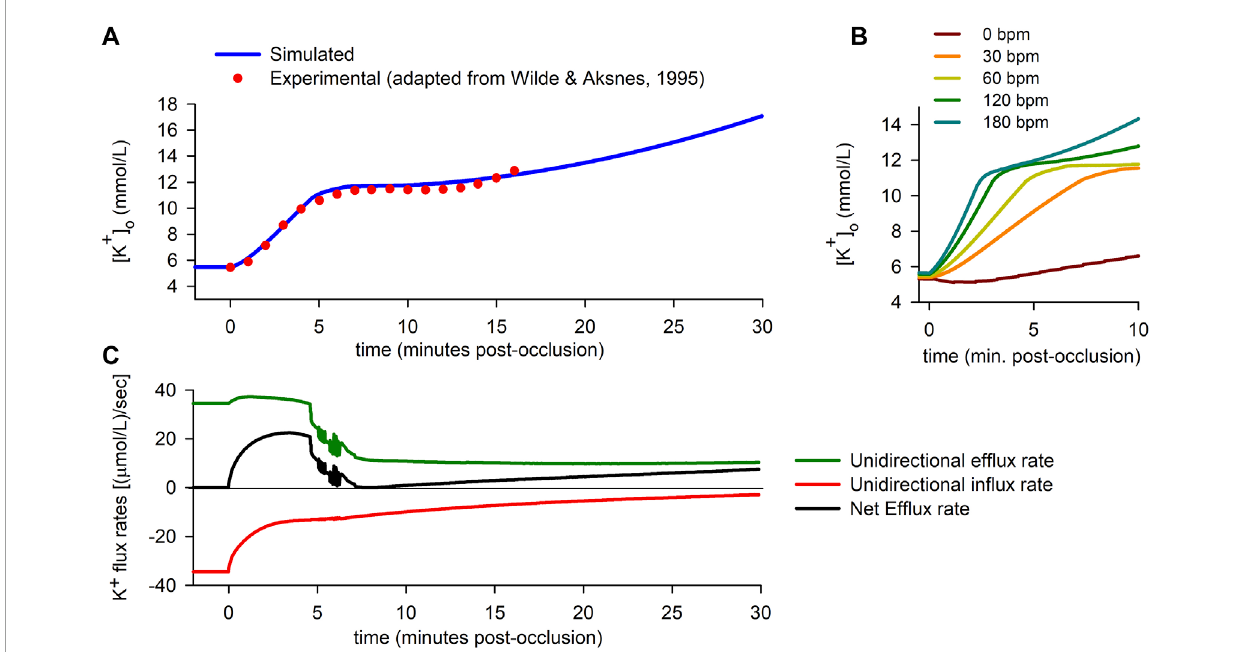
FIGURE 2 Extracellular potassium accumulation and transmembrane potassium fluxes. (A) : Extracellular potassium concentration ([ K + ] o ) vs. time in an isolated ventricular cardiomyocyte subject to progressive ischemia. Solid blue line: simulated result; red circles: experimental data adapted from Wilde and Aksnes (Wilde and Aksnes, 1995). (B) : Simulated time course of [ K + ] o for different heart rates (bpm: beats per minute). (C) :Unidirectional potassium efflux rate (green), influx rate (red) and net efflux rate (black) vs. time.